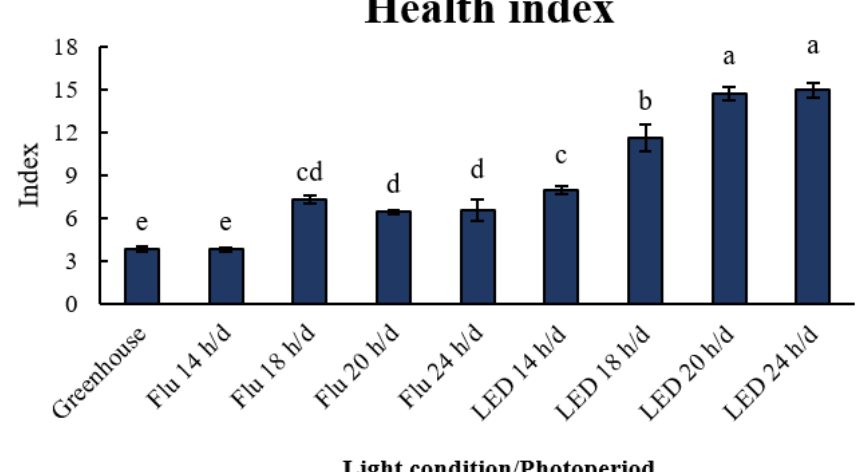
Figure 2. The effect of photoperiods on the health index of tomato seedlings. The tomato seedlings were recorded at 14 days after planting. Mean and standard error are calculated from four replicates. Values with different letters in each treatment differ significantly at p ≥ 0.05. Flu: fluorescent light at 150 µmol/m 2 /s, LED: LED light at 200 µmol/m 2 /s, ratio R60:B40.